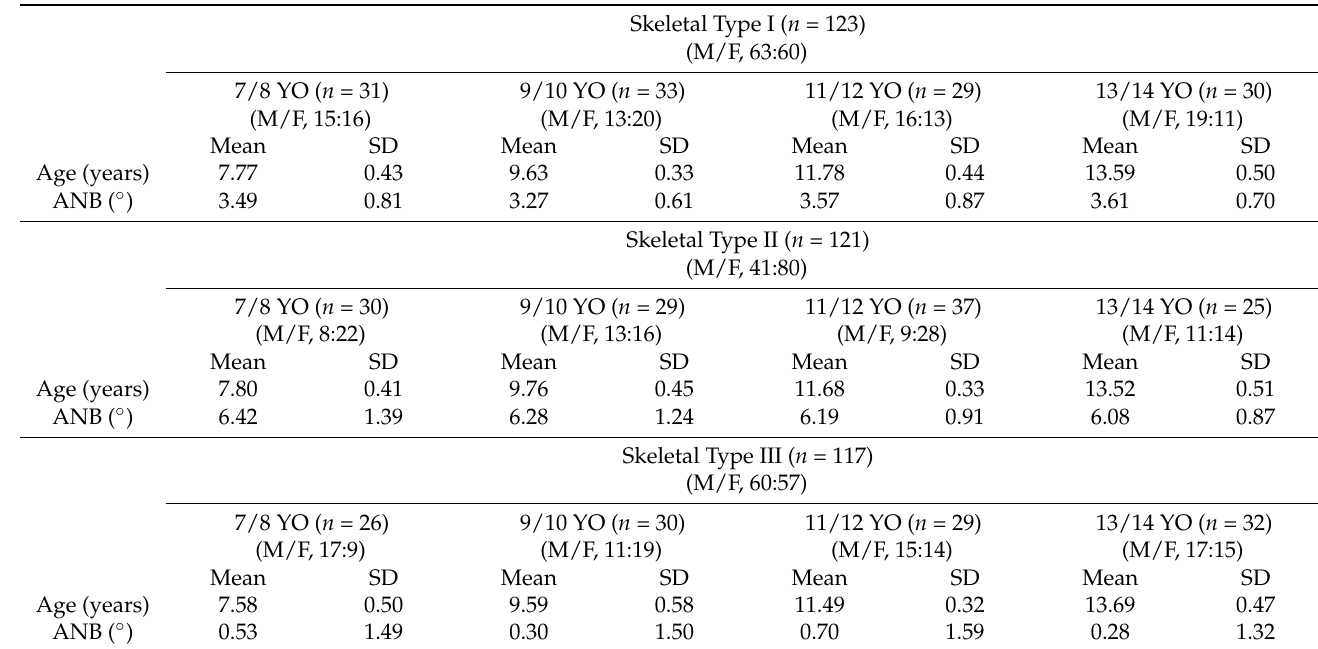
Table 1. Distribution of ANB ( ◦ ) values based on the subjects’ age and skeletal